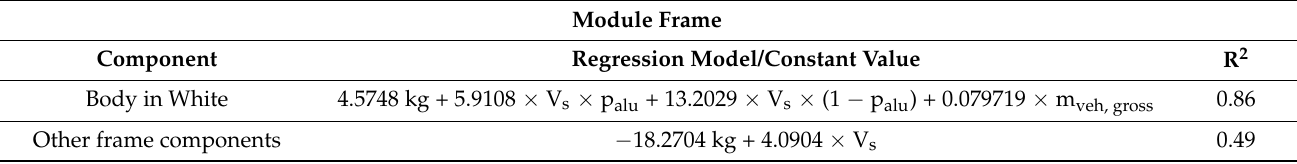
Table A3. Empirical Models for the Frame